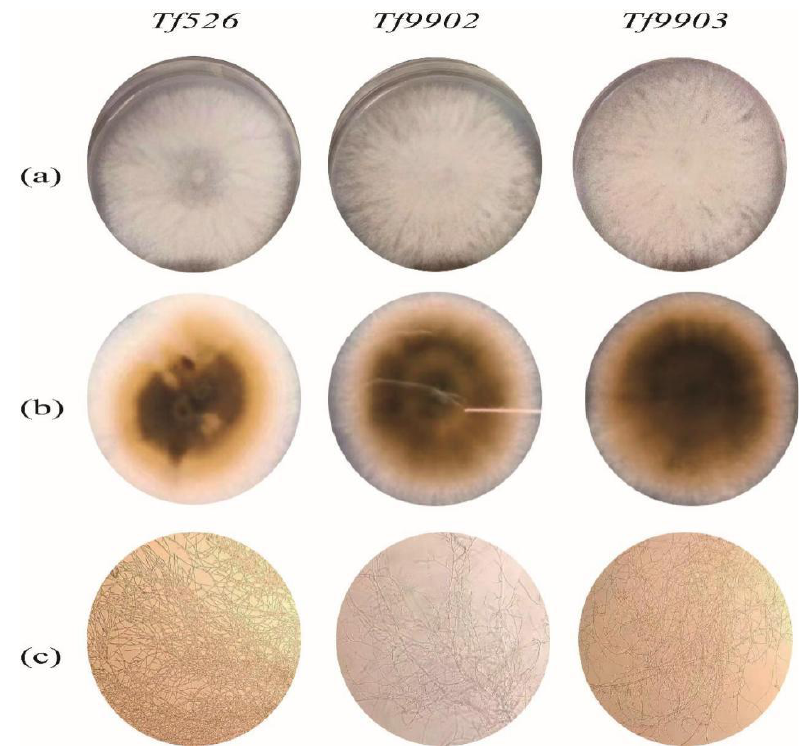
Figure 1. Microscopic observation of three strains of Tremella fuciformis ( Tf526 , Tf9902 , Tf9903 ) on the solid culture plate. ( a ) Front view of Tremella fuciformis ( Tf526 , Tf9902 , Tf9903 ) on a culture plate. ( b ) Back view of Tremella fuciformis ( Tf526 , Tf9902 , Tf9903 ) on a culture plate. ( c ) Mycelium micro examination (200×) of Tremella fuciformis ( Tf526 , Tf9902 , Tf9903 ) obtained by liquid culture.